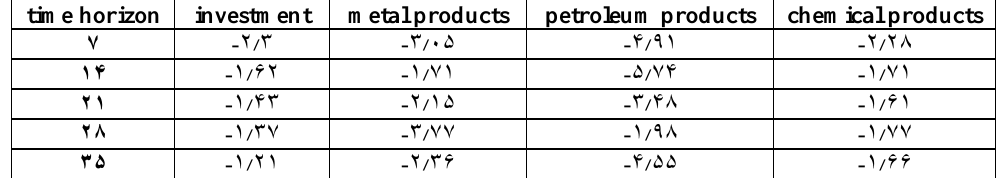
Table 14. Predicting the switching regime VaR in the 7–35-week time horizon for the designated industries